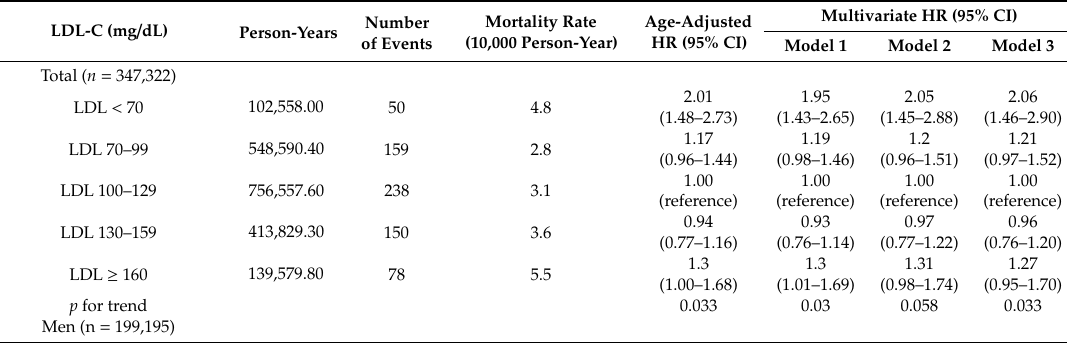
Table 4. Risk of cancer mortality according to baseline LDL-C levels excluding subjects who died within 3 years of follow up in Kangbuk Samsung Health